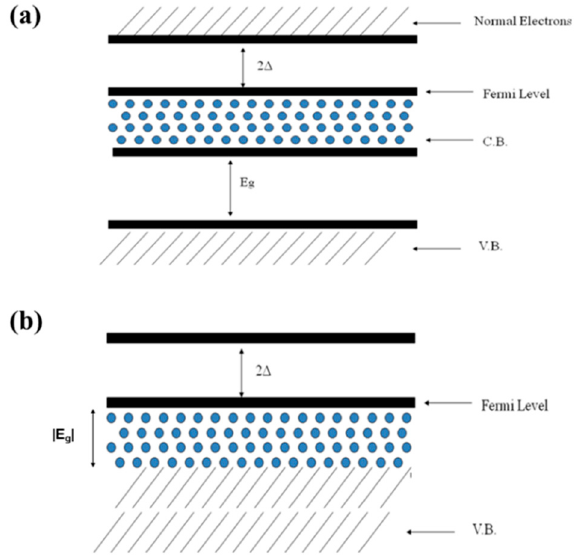
Figure 3. The band gap E g and the superconducting gap 2 ∆ are shown, where C.B. and V.B. denote the conduction band and the valence band, respectively: ( a ) at superconducting states according to conventional models; ( b ) at superconducting states according to our model.